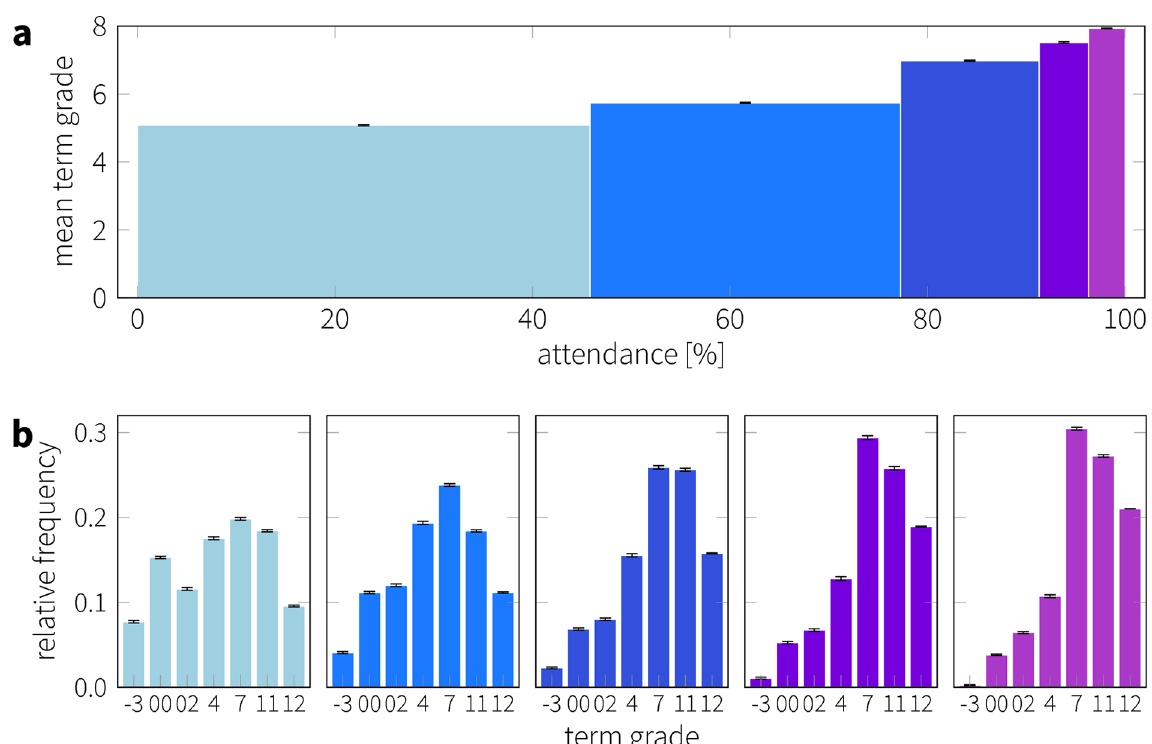
Fig 4. Class attendance and performance. a) Illustration of the five groupsbased on class attendance. Bars indicate groups of equal size, width corresponds to the span of attendance percentagein the specific group and height shows the mean term GPA. b) Grade distribution inside each attendance quintile.Each group includesat least 373